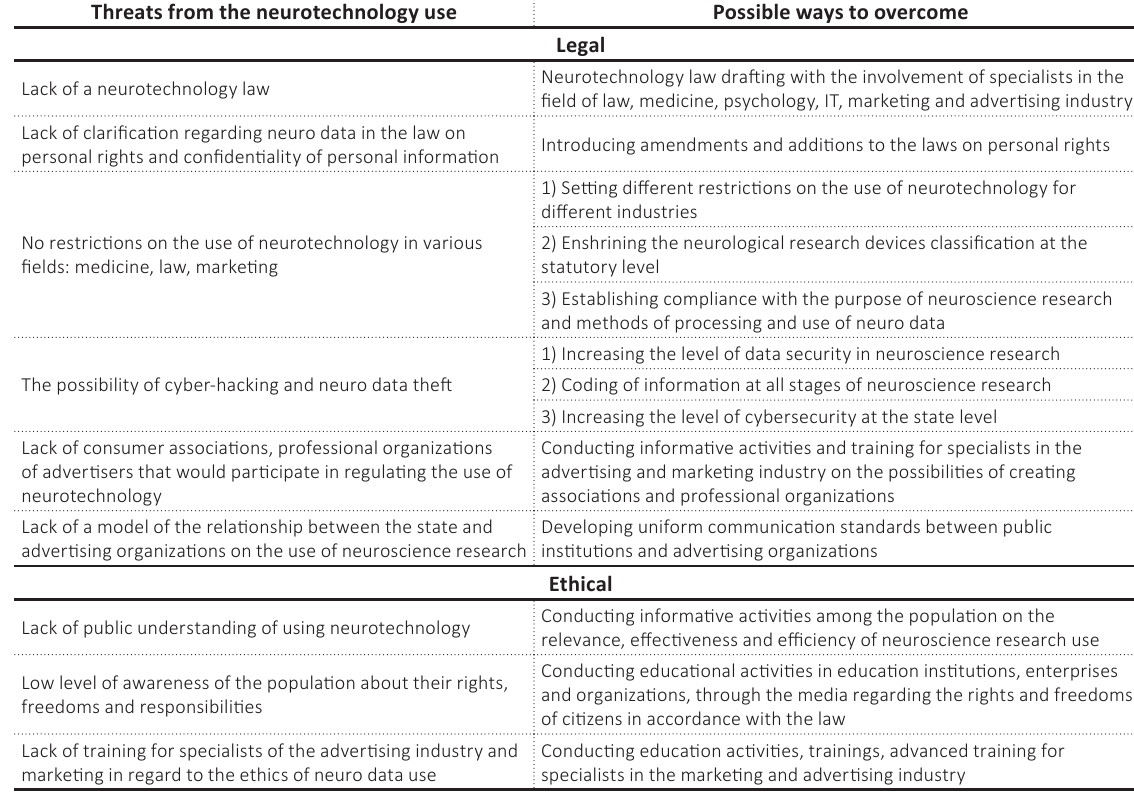
Table 1. Disadvantages of using neurotechnology in the advertising industry and possible solutions Threats from the neurotechnology